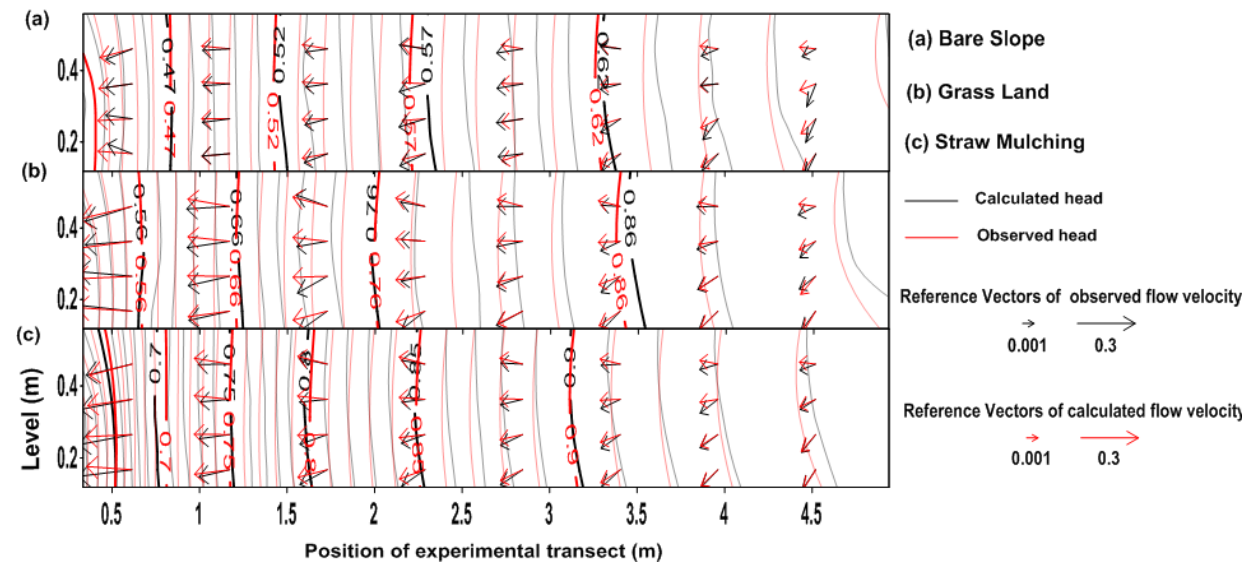
Figure 9. Flow field of the groundwater at 100 min for three scenarios: ( a ) Bare Slope; ( b ) Grass Land; ( c ) Straw Mulching (The direction of reference vectors stands for flow direction of groundwater and the size of reference vectors only means high or low velocity of flow, not the exact value of flow